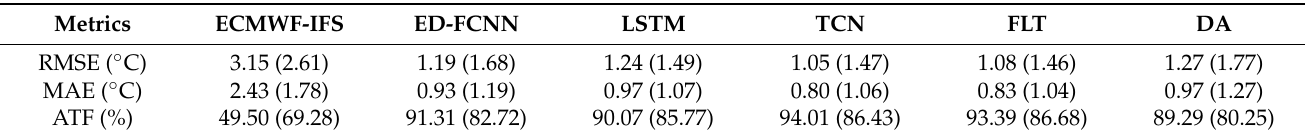
Table 4. Mean verification metrics for extreme events related to maximum temperature on the test set for each neural network